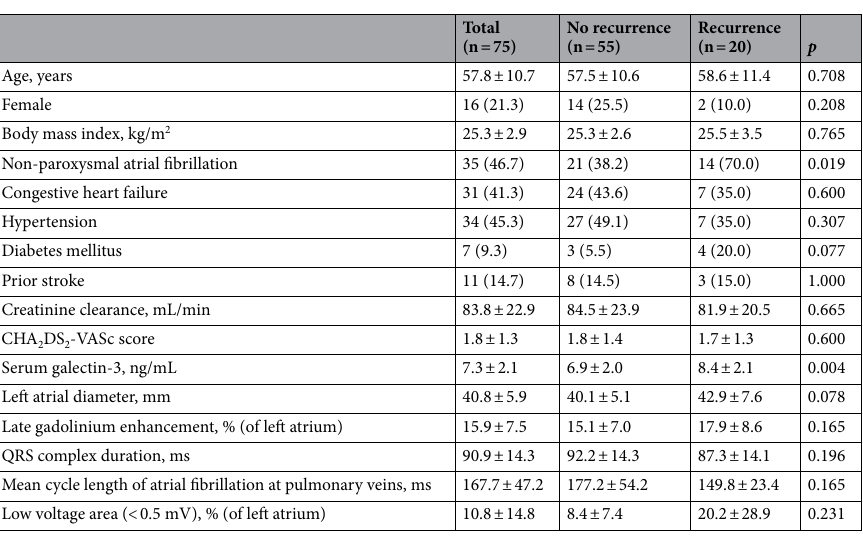
Table 1. Baseline characteristics for recurrence after catheter ablation. Data are presented as n (%) or mean ± standard deviation.